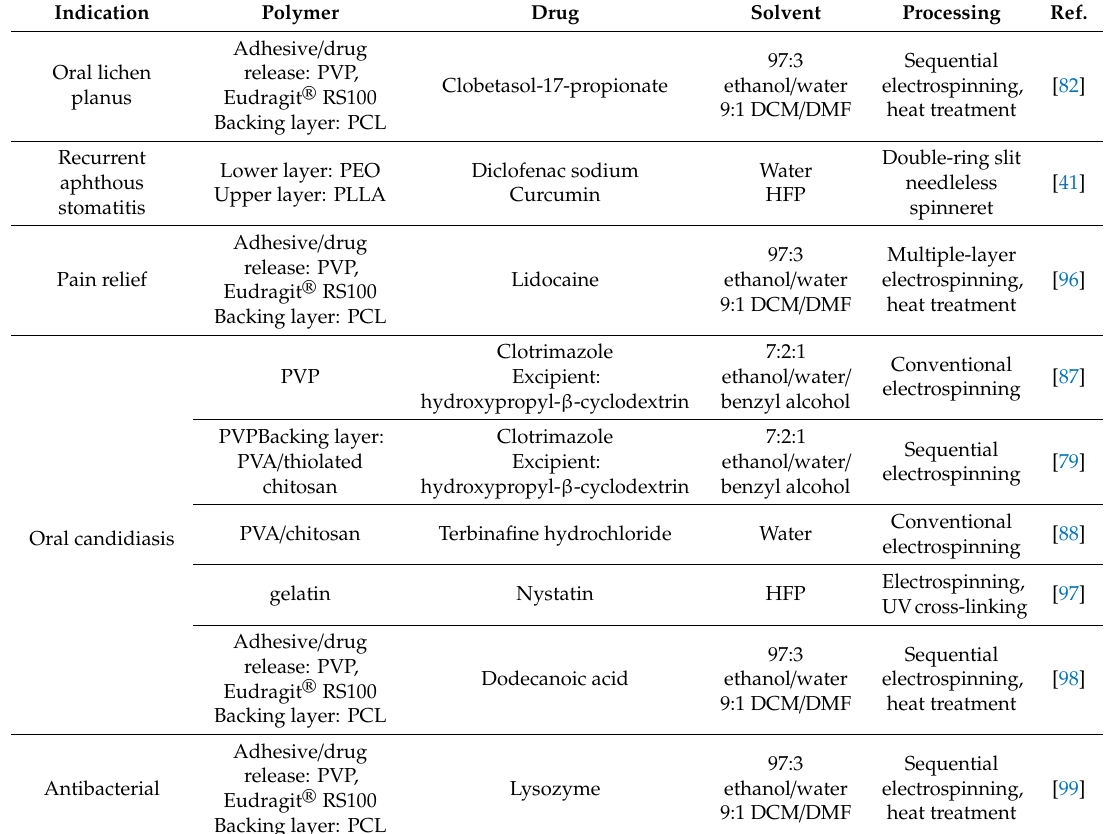
Table 2. Electrospun mucoadhesives under development for use in oral